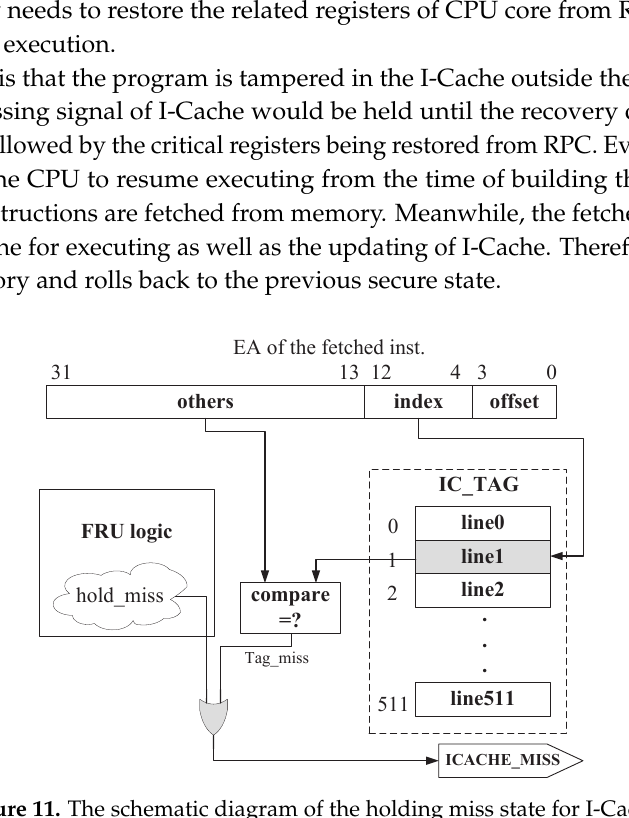
Figure 11. The schematic diagram of the holding miss state for